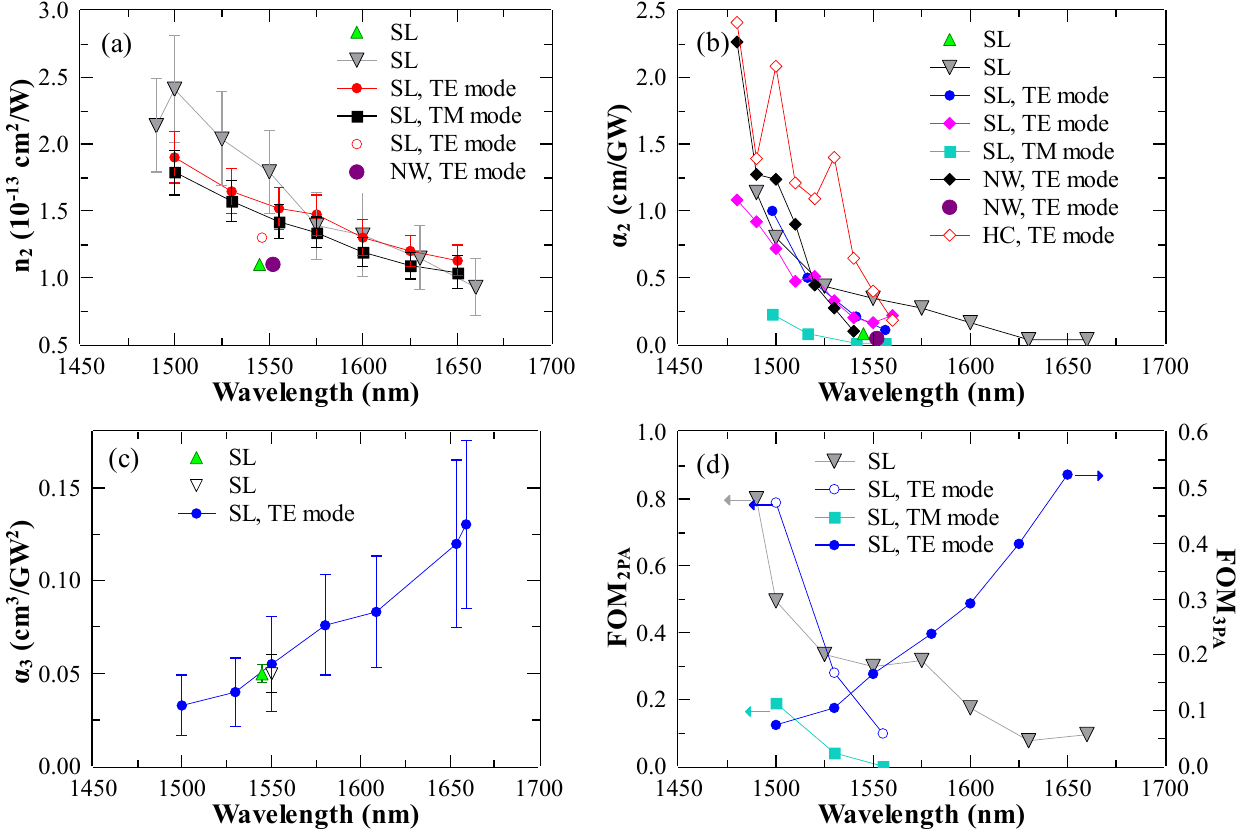
Figure 10. The spectra of the nonlinear coefficients of AlGaAs waveguides with Al 0.18 Ga 0.82 As guiding layer: ( a ) nonlinear refractive index, ( b ) 2PA coefficient, ( c ) 3PA coefficient, and ( d ) nonlinear FOM associated with 2PA and 3PA, as defined by Equations (10) and (11). References: • [9]; • , (cid:4) ,